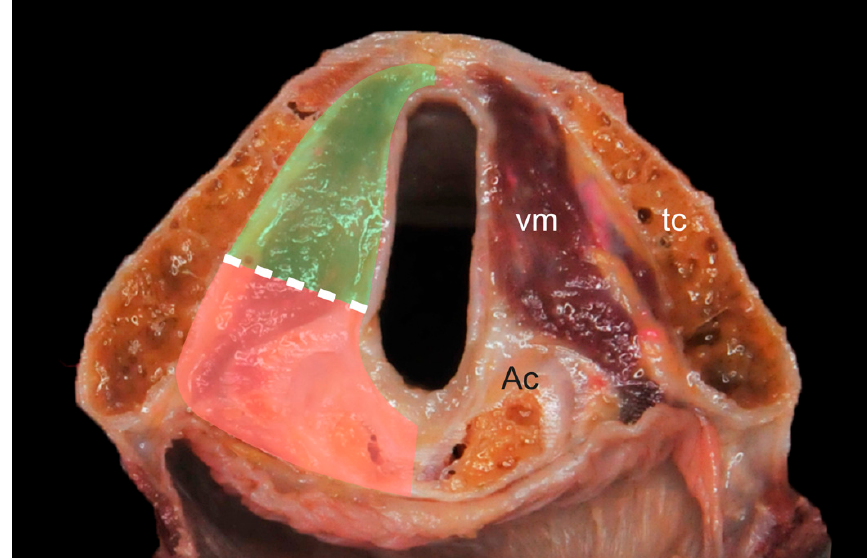
Figure 1. Anatomical section representing the glottic plane on a transverse section: dashed line (“magic plane” according to Succo et al. [4] ) indicates the limit dividing the anterior (green) from the posterior (red) laryngeal compartments. Legend: Ac, arytenoid cartilage; tc, thyroid cartilage; vm, vocal muscle.